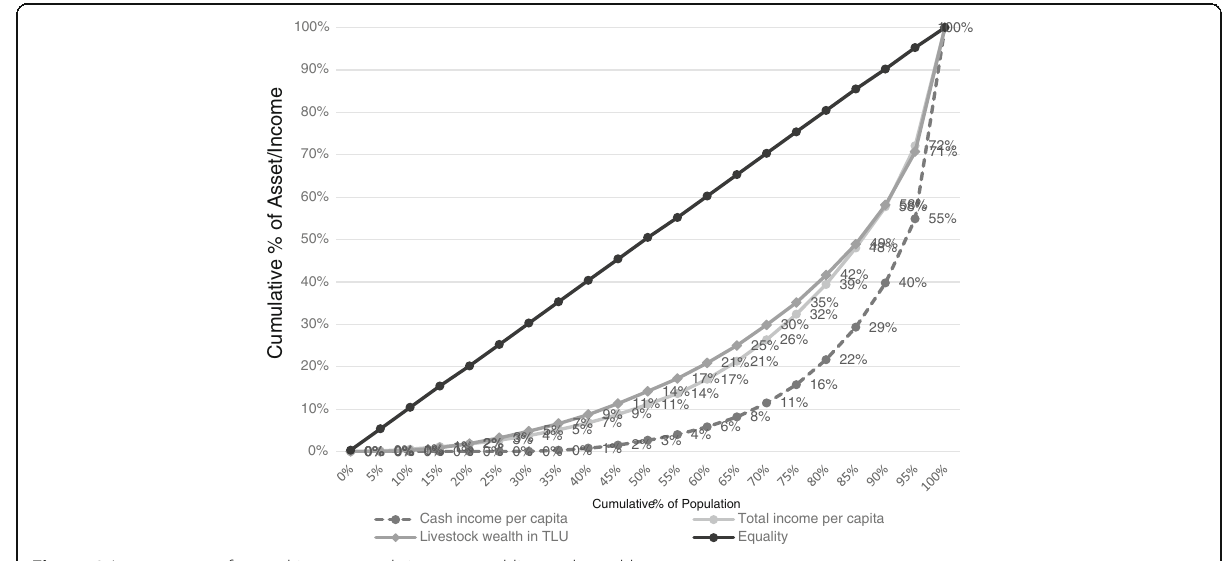
Figure 3 Lorenz curves for total income, cash income, and livestock